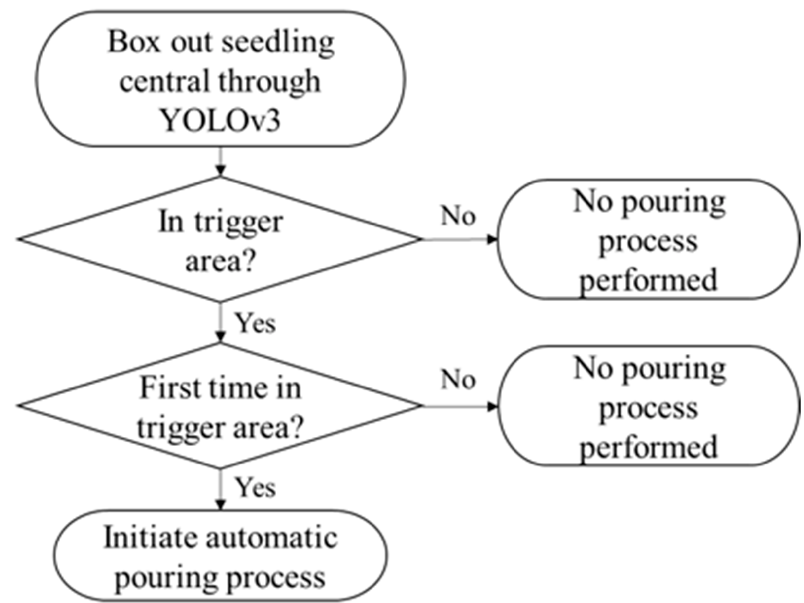
Figure 14. Flow chart of triggering for the watering process.